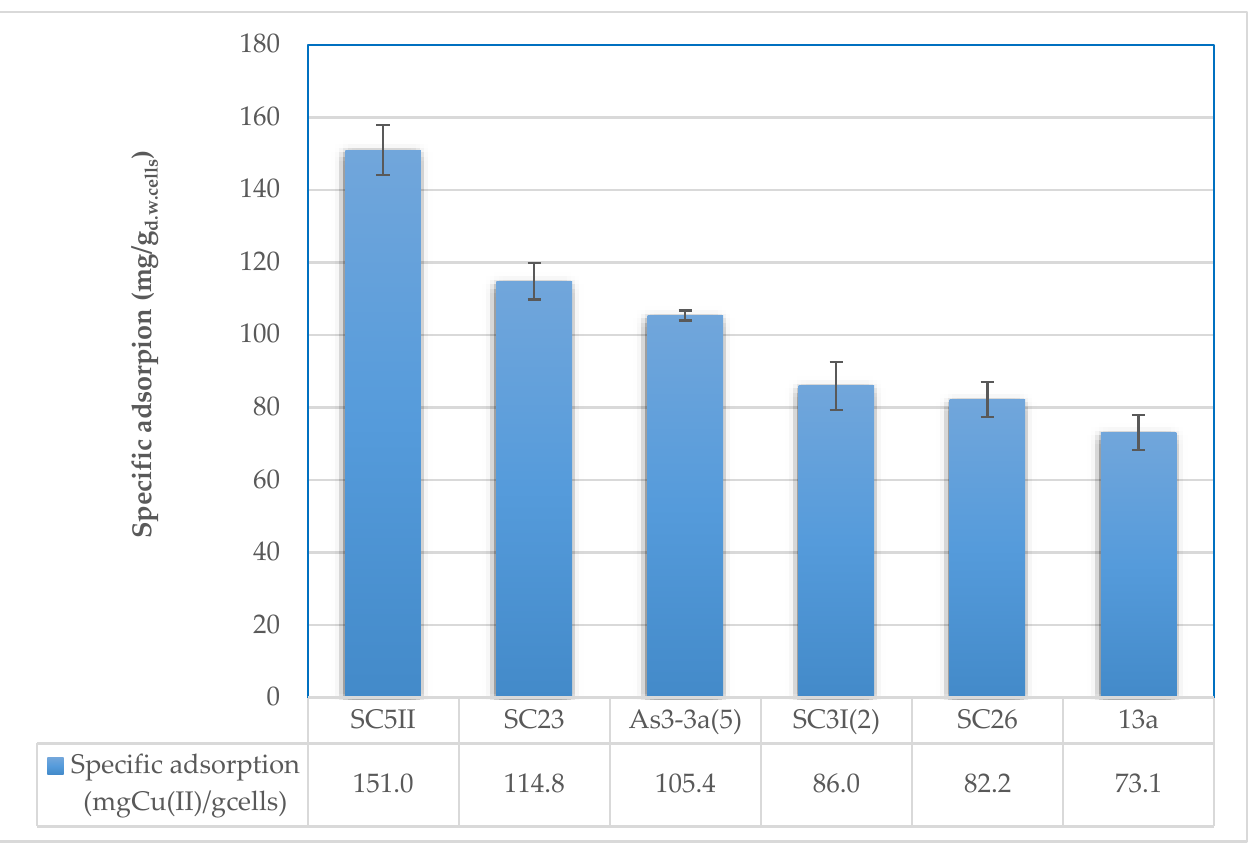
d . w . cells ) using